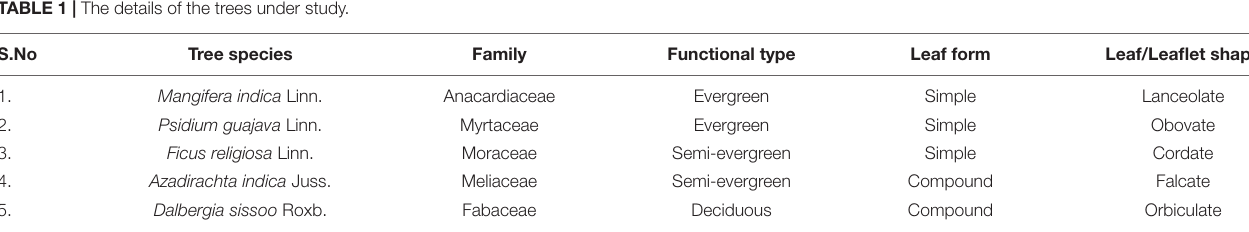
TABLE 1 | The details of the trees under